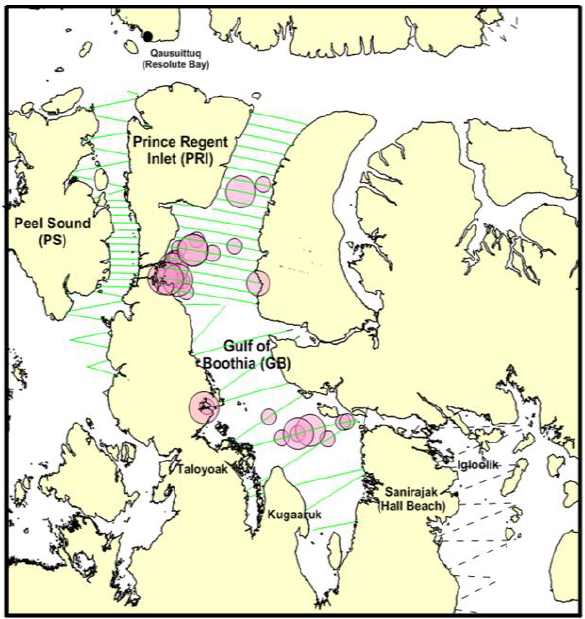
Figure 3. Somerset Island survey showing completed transects (green), un-completed planned transects (black dashed) and sightings of bowhead whales with symbol size proportional to group size (1 – 3).